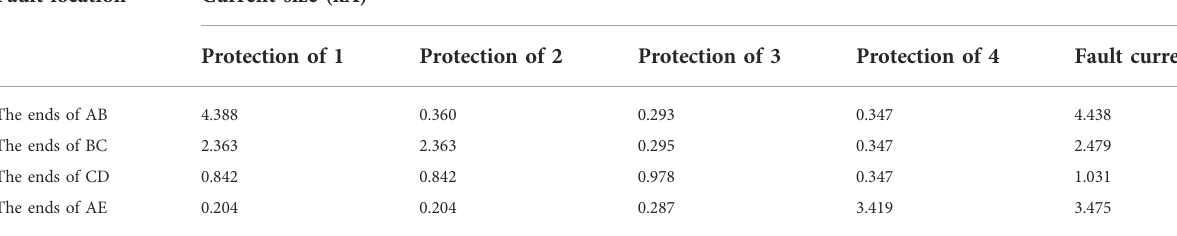
TABLE 2 Maximum short-circuit current at different positions when a three-phase short-circuit fault